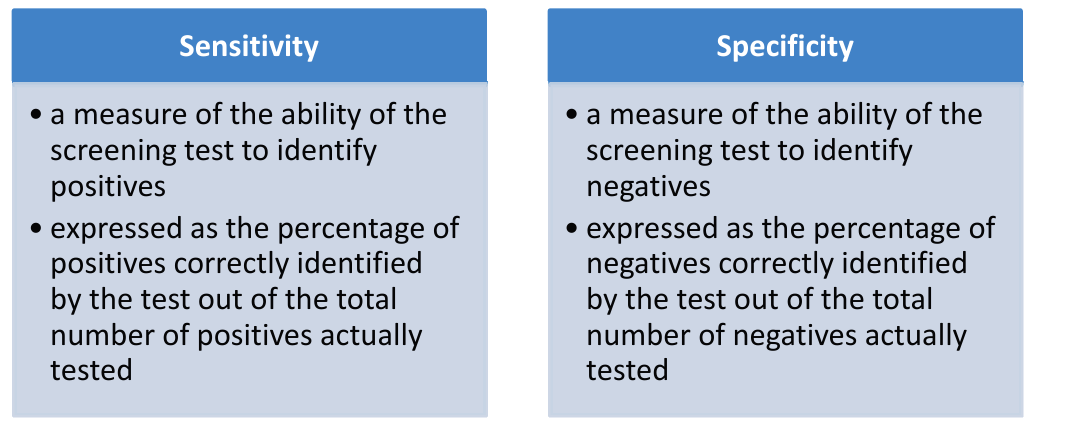
Figure 1. Definition of sensitivity and